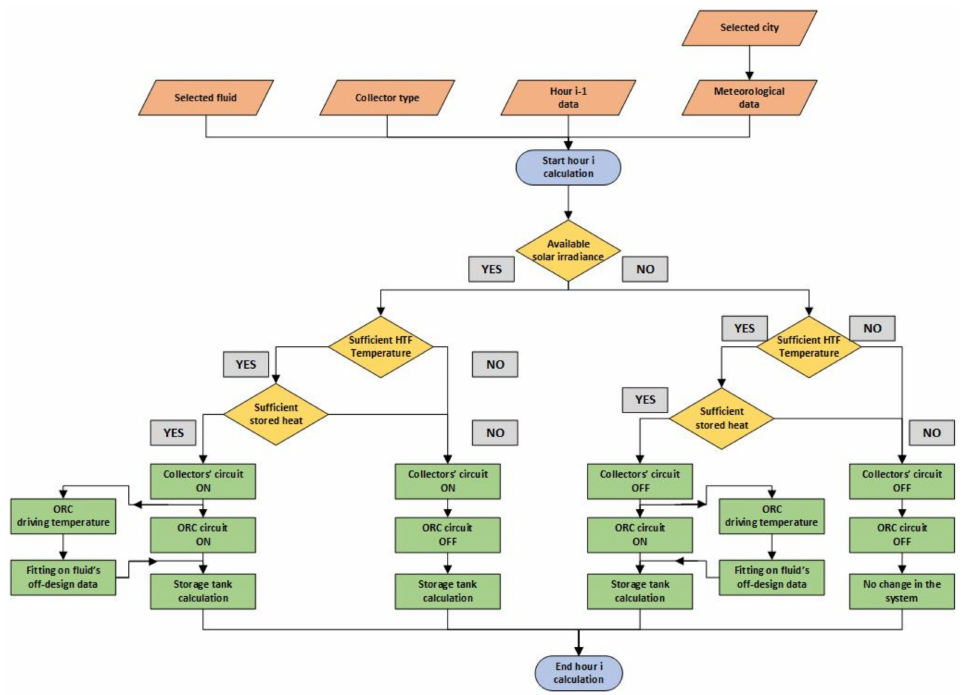
Figure A3. Flowchart of the overall system off-design modeling